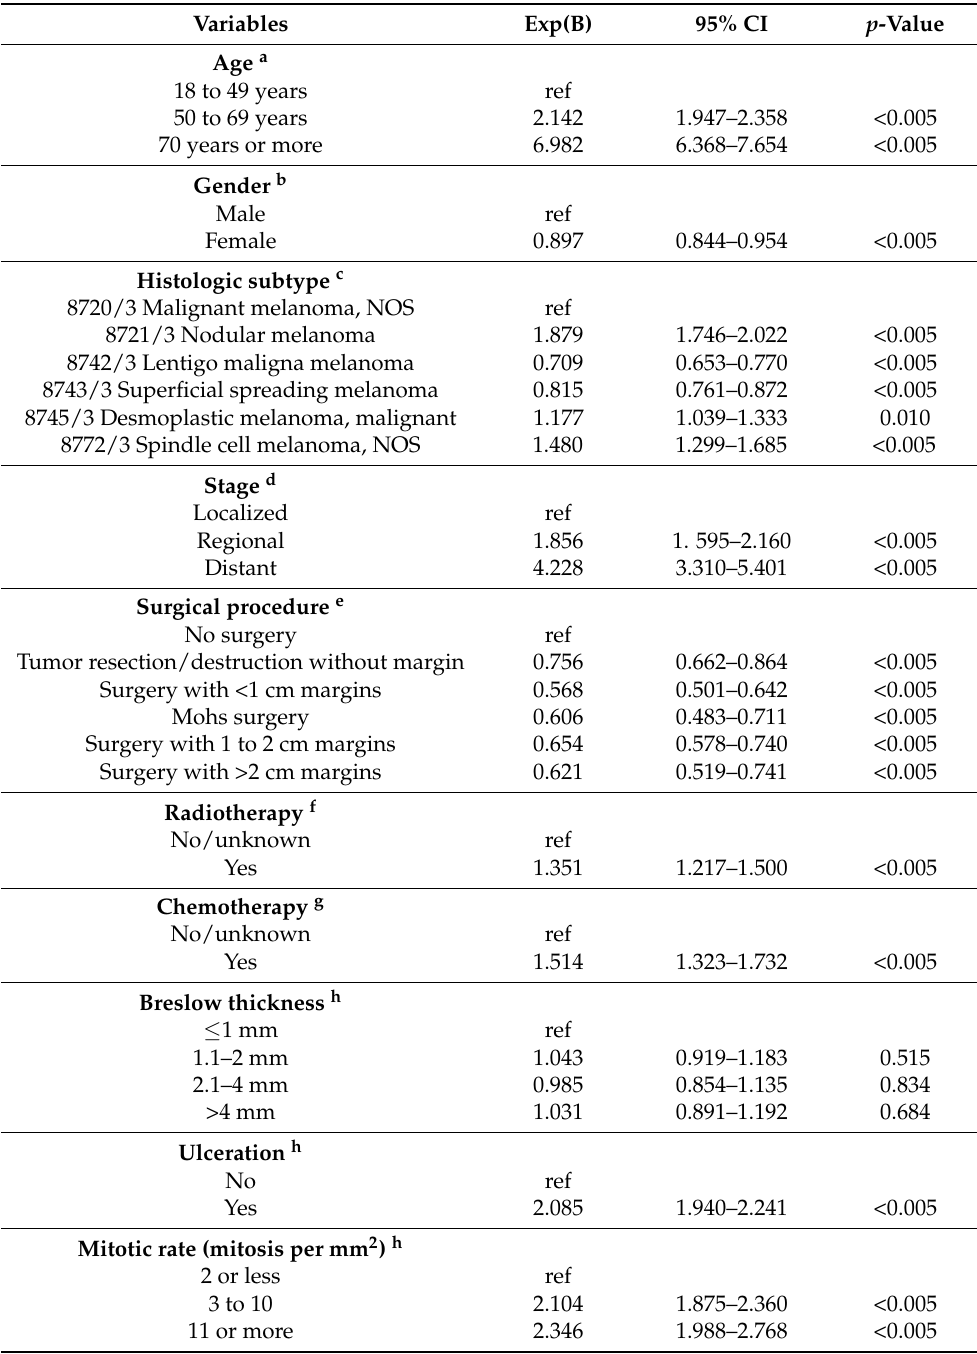
Table 3. Multivariable cox-regression of overall